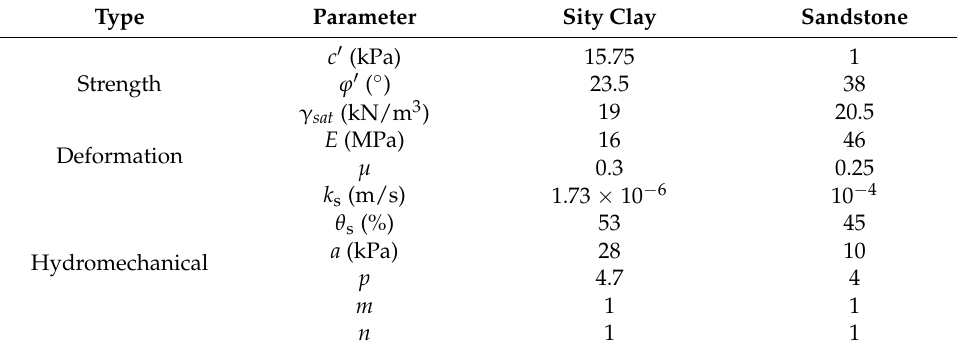
Table 1. Geotechnical and hydromechanical properties of the soil materials.